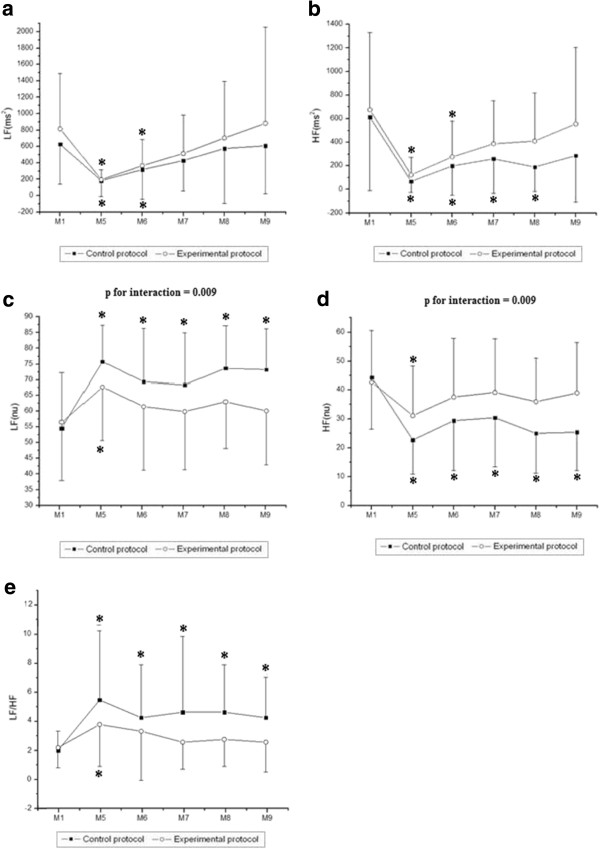
Values are means ± standard deviation. LFms2 (a), HFms2 (b), LFnu (c), HFnu (d) and LF/HF (e) during recovery and the comparison in control and experimental protocols. Final 5 minutes of rest (M1) and minutes of recovery: 5th to 10th (M5), 15th to 20th (M6), 25th to 30th (M7), 40th to 45th (M8), 55th to 60th (M9). *Different from M1 (p<0.05).